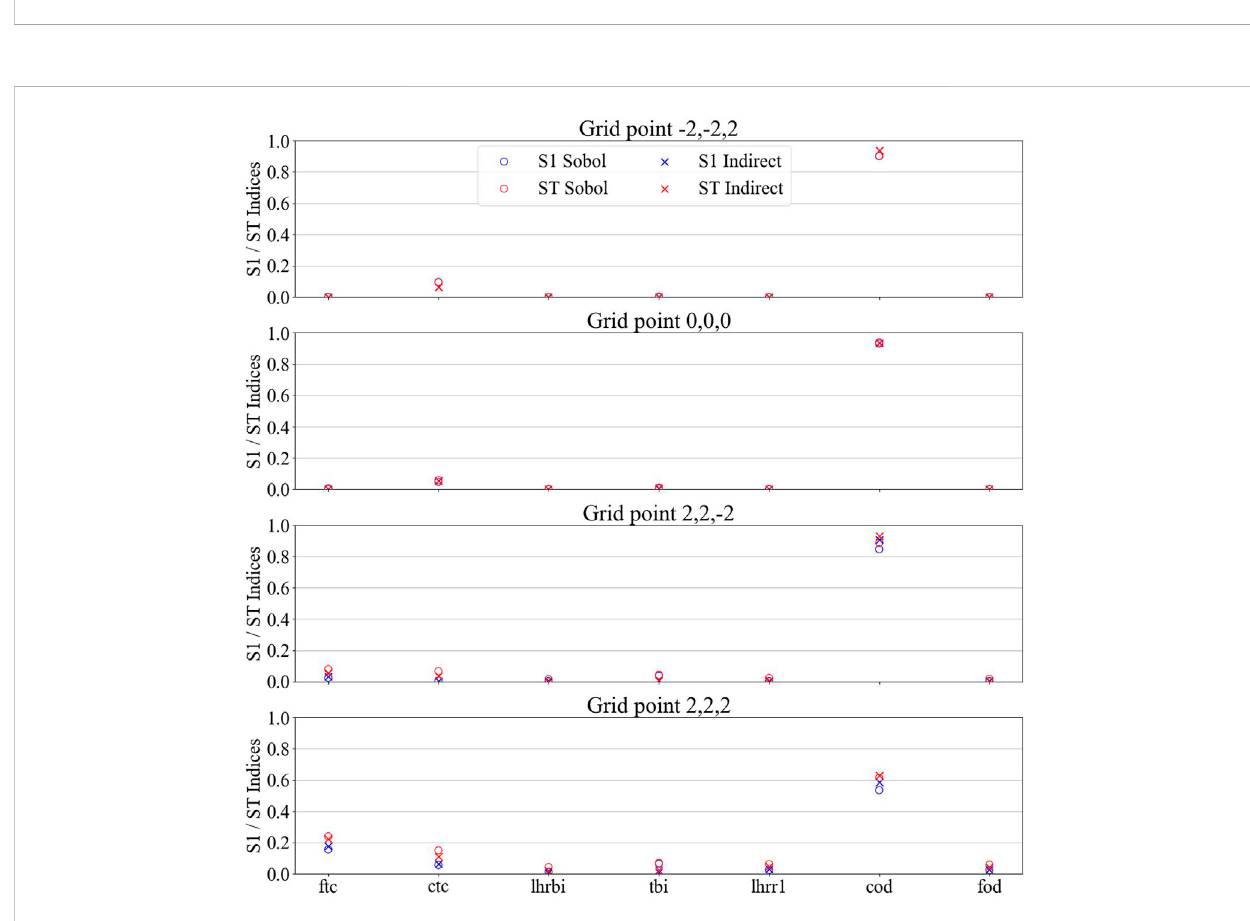
FIGURE 10 First (S1) and total (ST) Sobol indices for the maximal cladding axial elongation. Sobol means indices were calculated from the Sobol method while indirect means from the surrogate model.